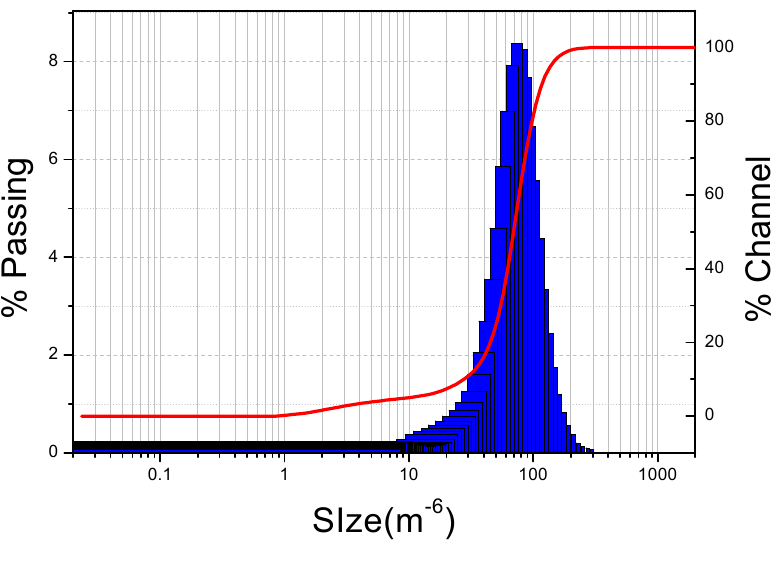
Figure 4. Particle size distribution of the raw TBL.